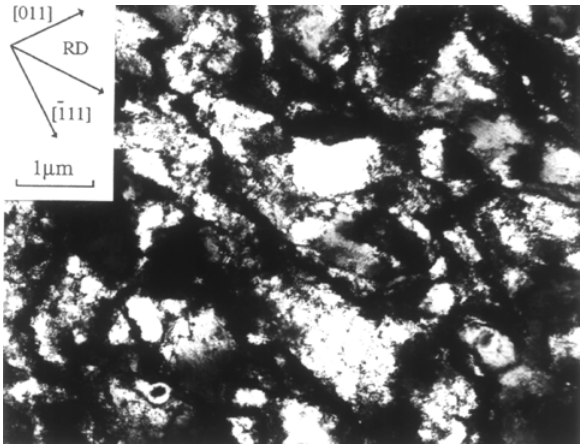
Figure 3. TEM observation of closed cell structure after a strain amount in rolling equal to 0.26 in a grain with <1 1 2> axis normal to the sheet plane (RD, rolling